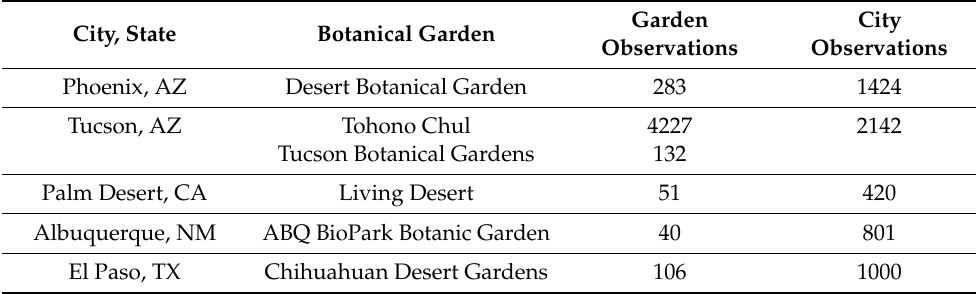
Figure 1. Locations of boundaries, botanical gardens (orange triangles), and community science observations (green crosses) used in the current study. City boundaries based on data from Open- StreetMap (2017). Table 2. Total number of unique observations for each city and botanical